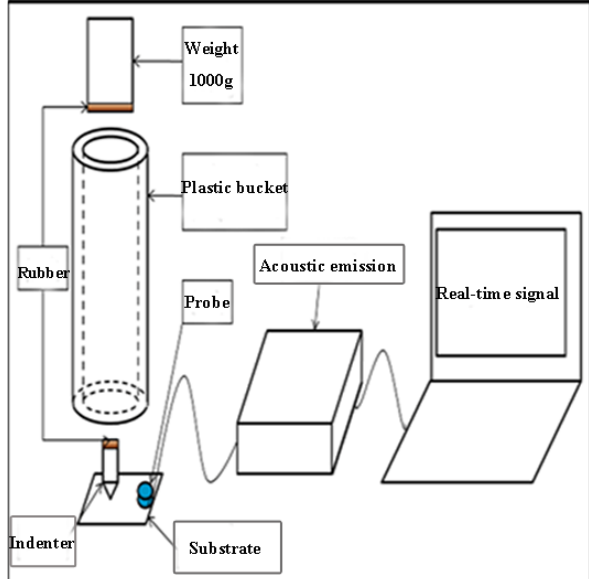
Figure 2: Schematic diagram of impact indentation